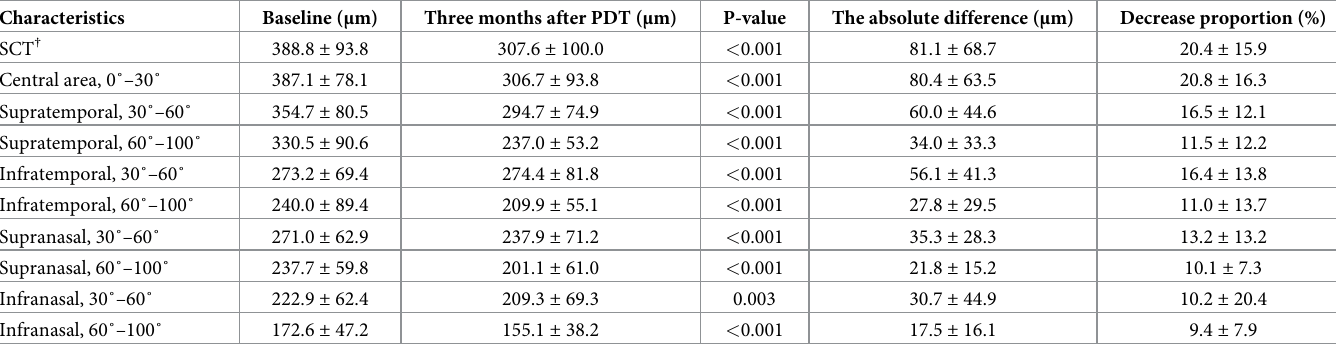
The data are shown as means with standard deviations. P-values were calculated using the Wilcoxon signed-rank test, comparing choroidal thickness before and 3 months after PDT. � photodynamic therapy; † subfoveal choroidal